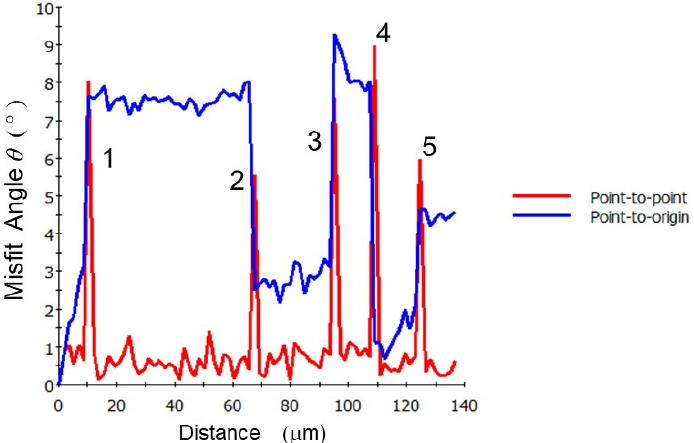
Figure 4. Misfit angle profile along the straight line drawn in Figure 3b. The red line shows the misfit between neighboring measured points, and the blue line shows the misfit of the measured point from the starting point.